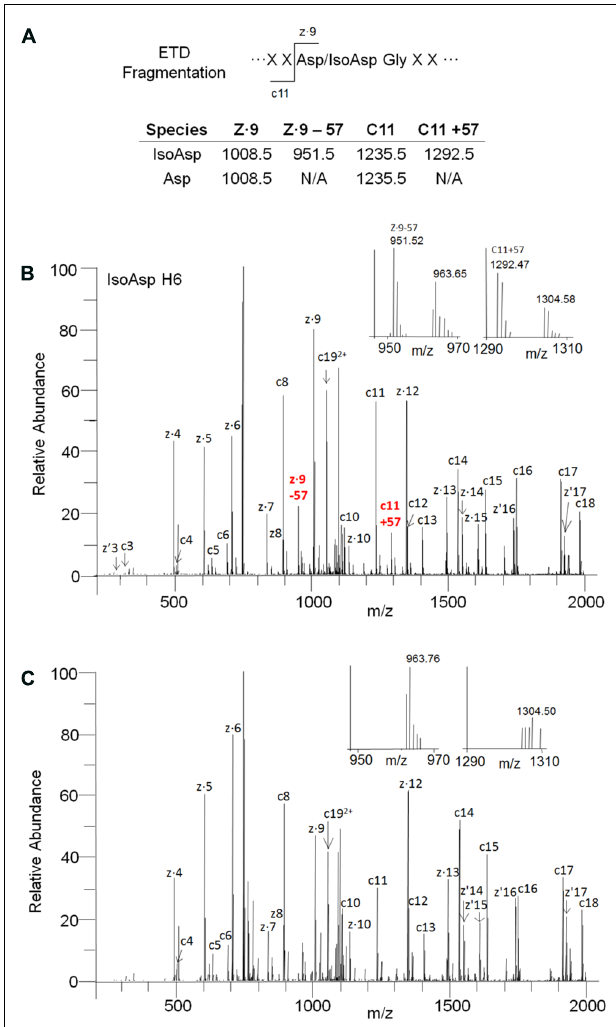
FIGURE 2 | Identification of isoAsp55 in stability samples. (A) Observed masses for ETD fragmentation of isomerized and unisomerized H6 peptide. (B) ETD fragmentation pattern for the isoAsp H6 peptide.The inset is a zoomed view showing the reporter ions at 951.5 (z · 9–57 Da) and 1292.5 Da (c11 + 57 Da). (C) ETD fragmentation pattern for the H6 peptide.The inset is a zoomed view showing the lack of reporter ions at 951.5 Da and 1292.5